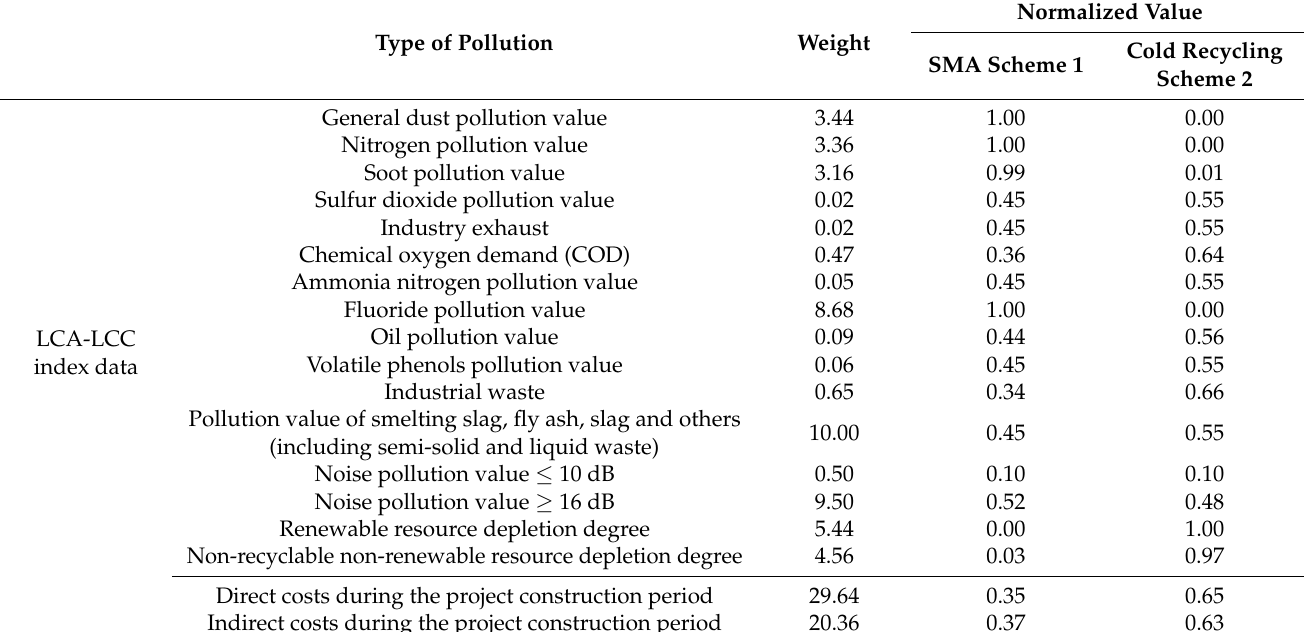
Table 3. LCA-LCC data and